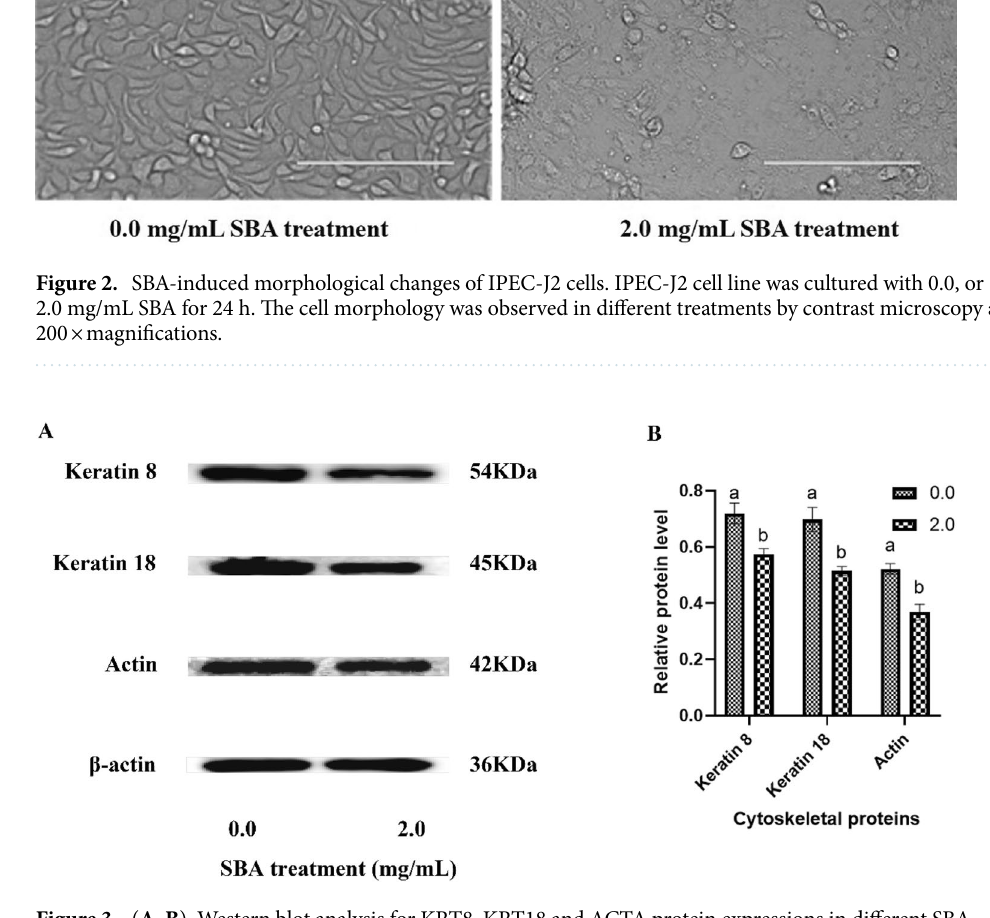
Figure 3. ( A , B ). Western blot analysis for KRT8, KRT18 and ACTA protein expressions in different SBA treatments. IPEC-J2 cells were treated with 0.0 or 2.0 mg/mL SBA for 24 h. ( A ). The representative images of KRT8, KRT18 and ACTA were detected by the western blot technique ( B ). The analysis of relative protein expression for KRT8, KRT18 and ACTA in 0.0 or 2.0 mg/mL SBA treatments. Data are represented as mean ± SEM. Different lowercase letters are significantly different ( p <